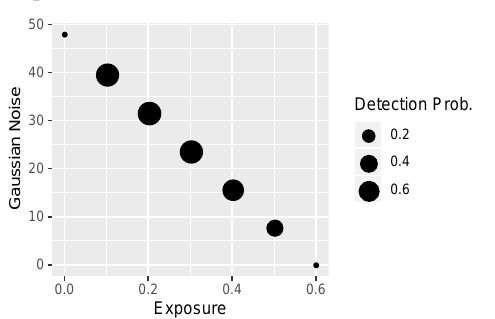
Figure 11. Face recognition detection [probability] for motion blur [ σ /degrees] and Gaussian noise [ σ /pixels].